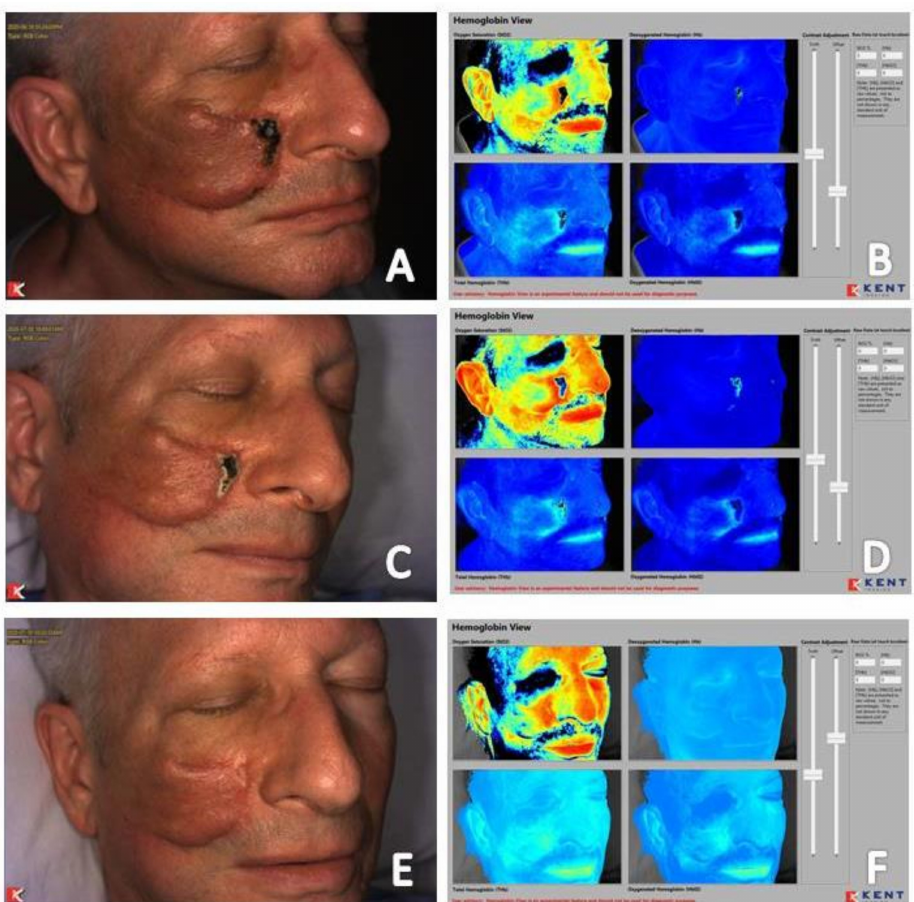
Figure 10. ( A ) Baseline clinical photograph; and ( B ) near-infrared image assessment, including total hemoglobin, deoxygenated hemoglobin, and oxygenated hemoglobin views, of patient that had undergone a flap for facial reconstruction following basal cell carcinoma excision (28 May 2020). Note the absence of signal within the wound bed ( B —Oxygen saturation window) and evidence of oxygenated hemoglobin moving toward the wound from the location of the flap ( B —Oxygenated hemoglobin window). ( C ) Clinical photograph and ( D ) near-infrared image assessment following five sessions of hyperbaric oxygen therapy. Note increase in signal within the wound bed ( D —Oxygen saturation window) and evidence of increased deoxygenated hemoglobin within the wound bed consistent with angiogenesis occurring from the venous side within the wound ( D —Deoxygenated hemoglobin window). ( E ) Clinical photograph and ( F ) near-infrared image assessment